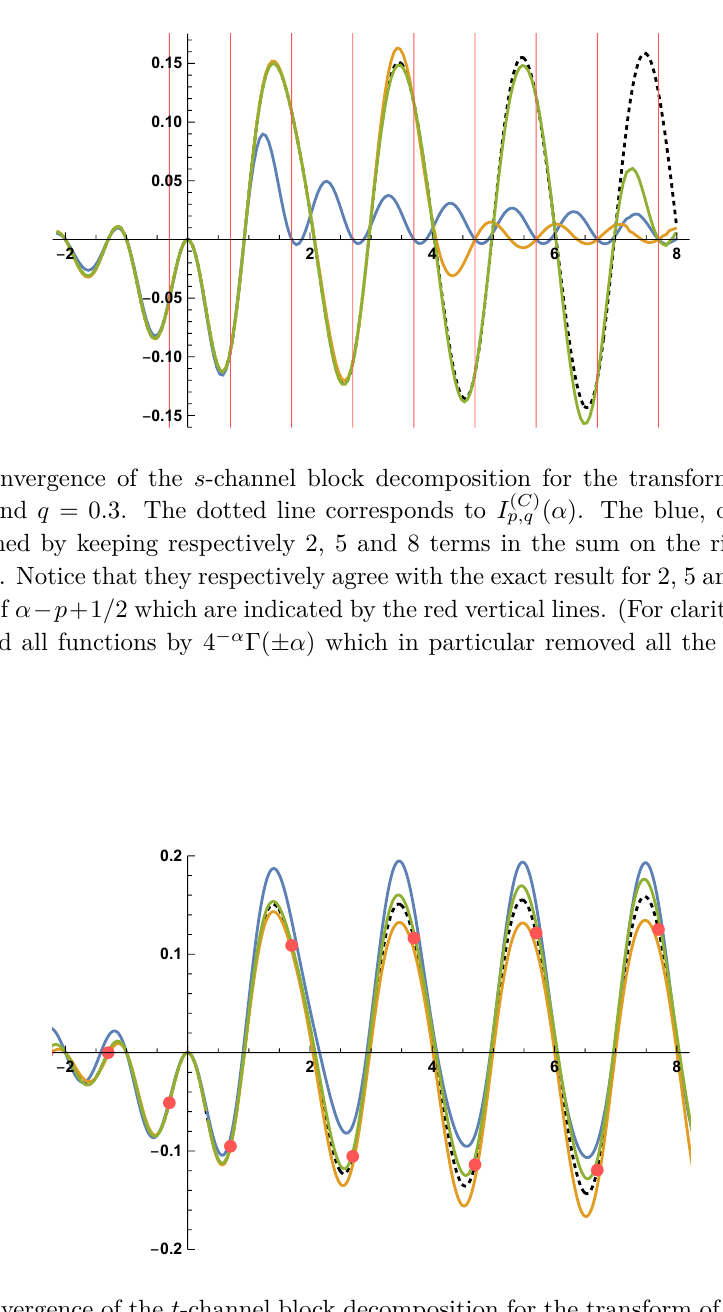
Figure 3 . Convergence of the t -channel block decomposition for the transform of z p (1 − z ) − q with p = 0 . 2 and q = 0 . 3 and with h = 0 . 7 . The dotted line corresponds to I ( C ) p,q ( α ) , and the red dots highlight the values at α = p − 1 / 2 + m , m integer, which are the OPE coefficients. The blue, orange and green lines are obtained by keeping respectively 2, 5 and 8 terms in the sum on the right-hand side of equation (4.15). (For clarity of presentation we have divided all functions by 4 − α Γ( ± α ) which in particular removed all the poles at positive integer α